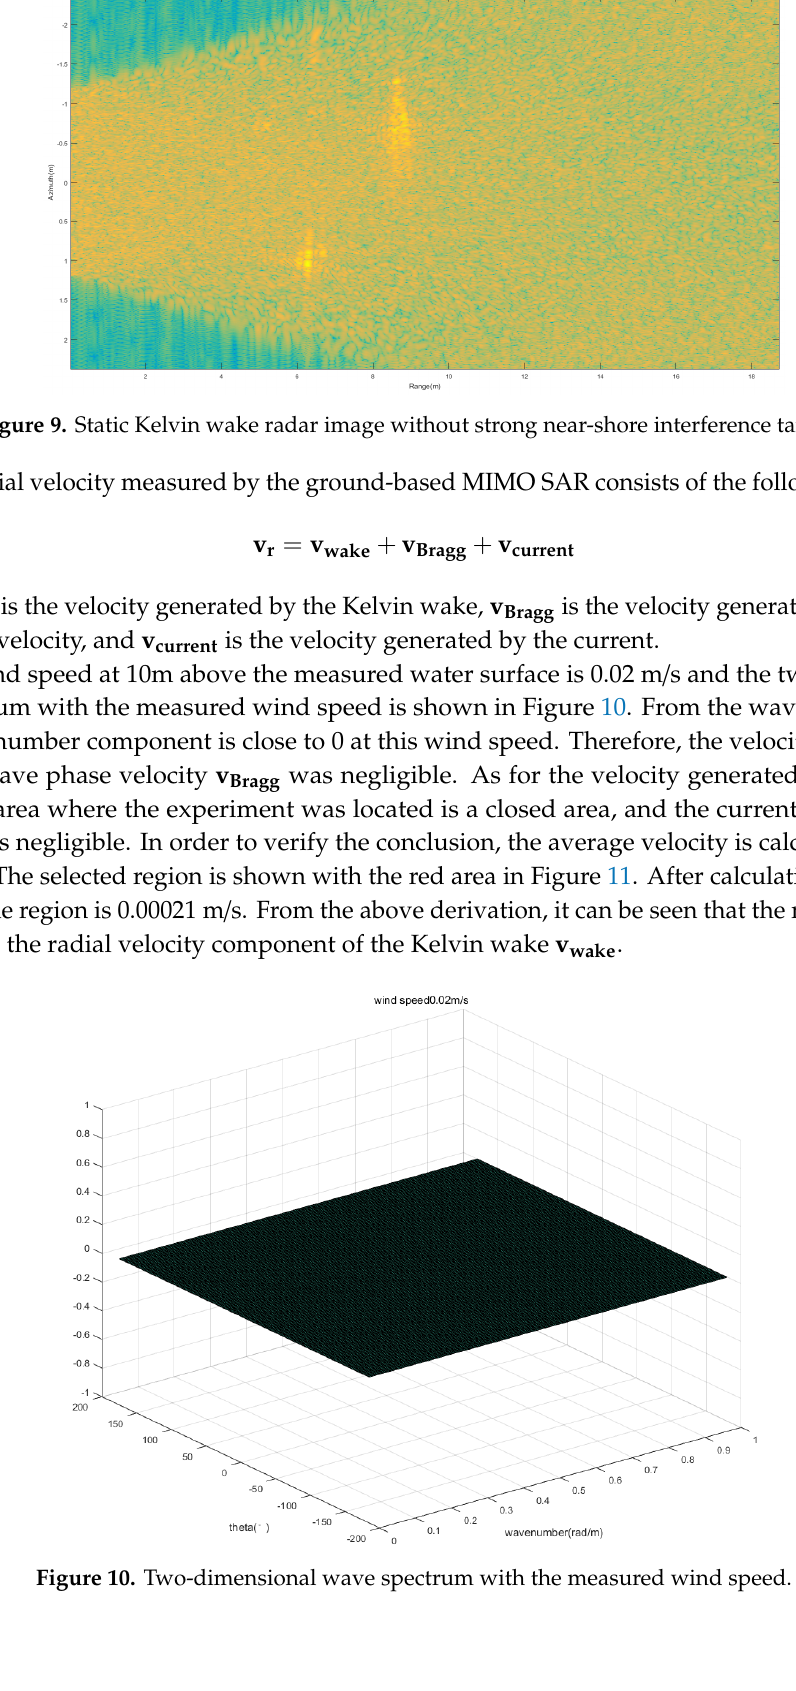
Figure 11. Kelvin wake radial velocity image.